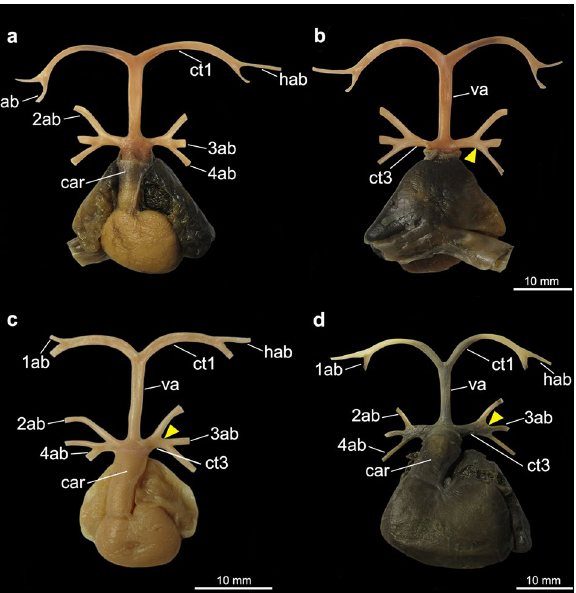
Figure 4. Heart and afferent branchial arteries in Rhinobatiformes and Rhiniformes. ( a ) ventral and ( b ) dorsal views of Pseudobatos horkelii; ( c ) ventral view of Glaucostegus granulatus ; ( d ) ventral view of Rhynchobatus palpebratus , 1ab-4ab 1st-4th afferent branchial arteries; car conus arteriosus ; ct1 common trunk from the ventral aorta to the hyoidean and first afferent branchial arteries; ct3 common trunk from the ventral aorta to the three posteriormost afferent branchial arteries; hab hyoidean afferent branchial artery; va ventral aorta. Yellow triangles point to the common vessel that originates the third and fourth afferent branchial arteries.